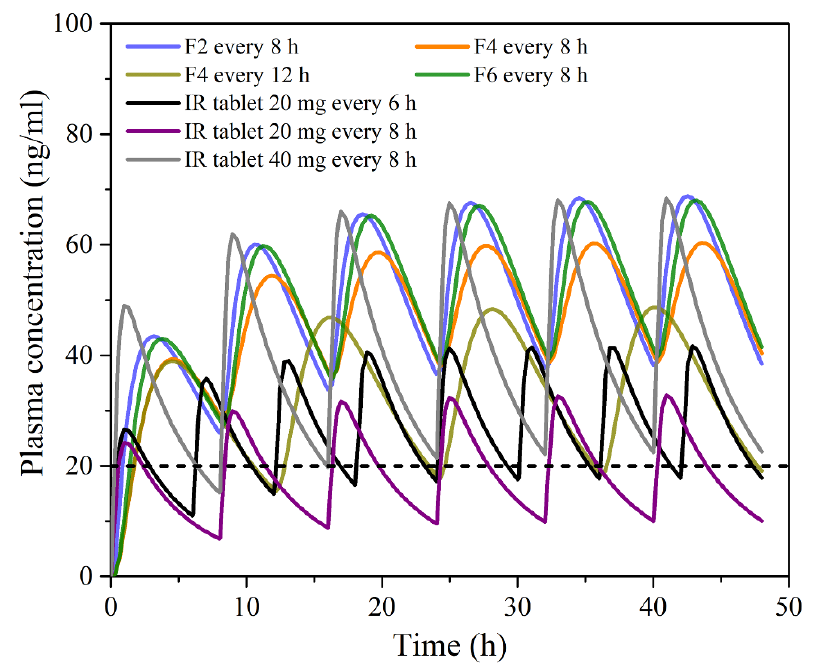
Figure 8. Mean predicted plasma concentration-time profiles following multiple dosing of the tested 20 mg PRH buccal films, and 20 mg and 40 mg IR tablets in 50 virtual subjects; the dotted line represents the minimum effective concentration.